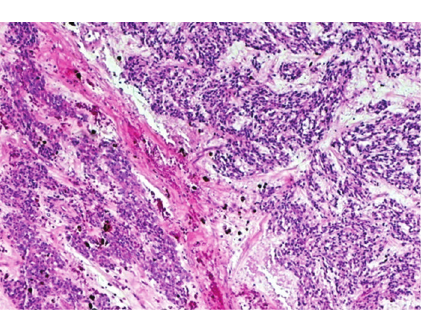
Figure 4: The distinction between epithelioid type (lower side right) and spindle cell type (upper side left) (HE).